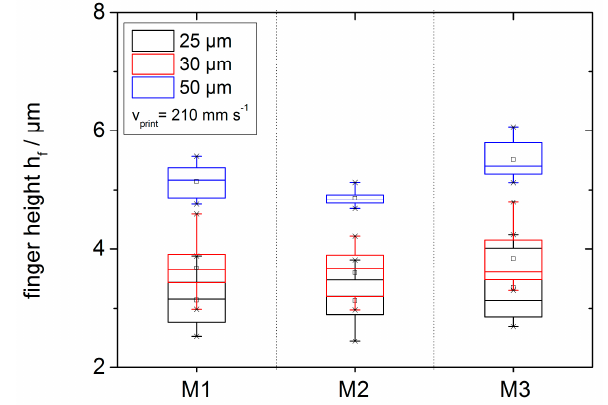
Figure 11. Finger height h f results for M1, M2, and M3 printed through 25, 30, and 50 µm finger openings at v print = 210 mm s − 1 .